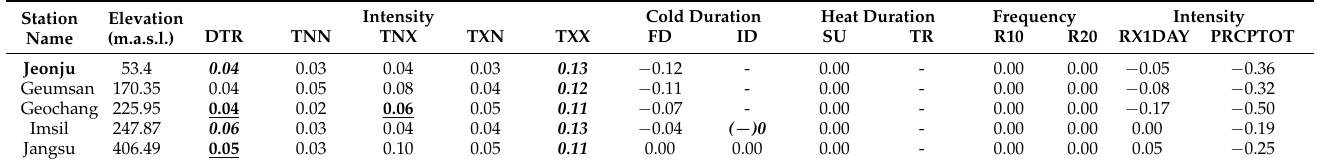
Table A9. Trend magnitudes for the month of March in the UGRB for 33 years (1988–2020).